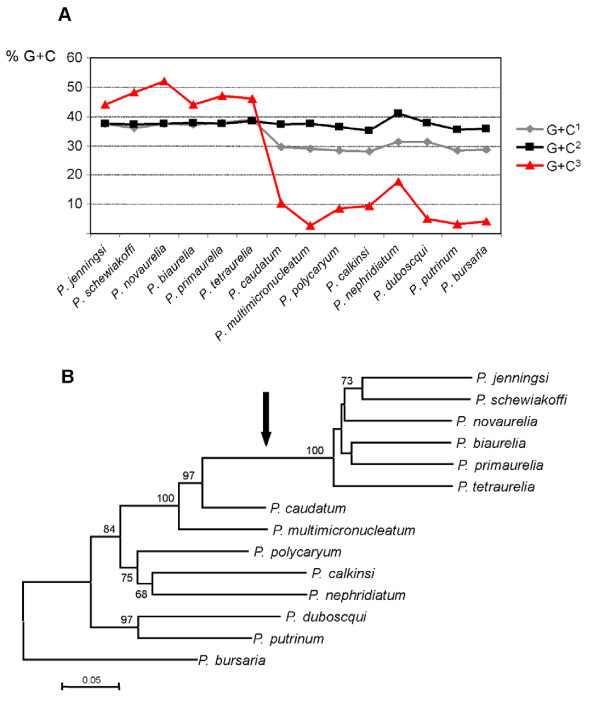
Mitochondrial nucleotide composition within the genus Paramecium. A) Guanine + cytosine content at 1st, 2nd and 3rd codon positions of the mitochondrial cox1 gene. B) Phylogenetic tree based on 776 bp of the cox1 gene. The numbers represent bootstrap values for 2,000 pseudoreplicates in the Neighbor Joining analysis and the scale bar equals 0.05 substitutions/site. The arrow indicates the phylogenetic position of the G+C shift.